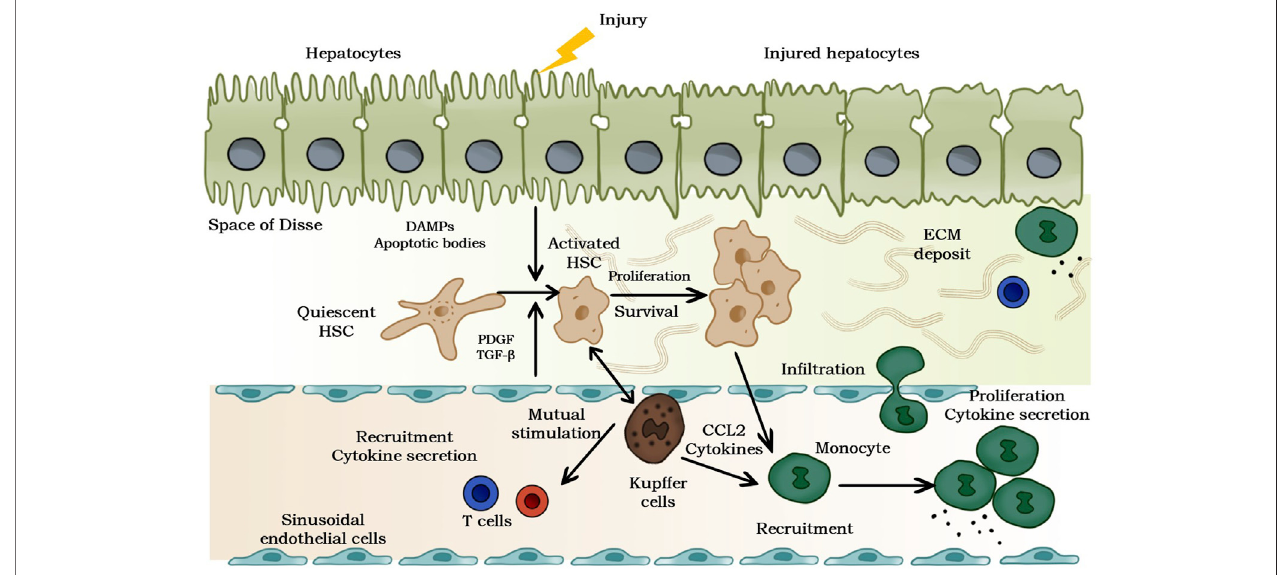
FIGURE 1 | Pathogenesis of liver fi brosis. The release of damage-related patterns (DAMPs). and apoptotic bodies can be induced by chronic hepatocyte injury, which activates hematopoietic stem cells and recruits immune cells. Moreover, the complex multidirectional interaction between activated hematopoietic stem cells and Kupffer cells and innate immune cells promotes transformation and differentiation into proliferation and ECM to generate myo fi broblasts.